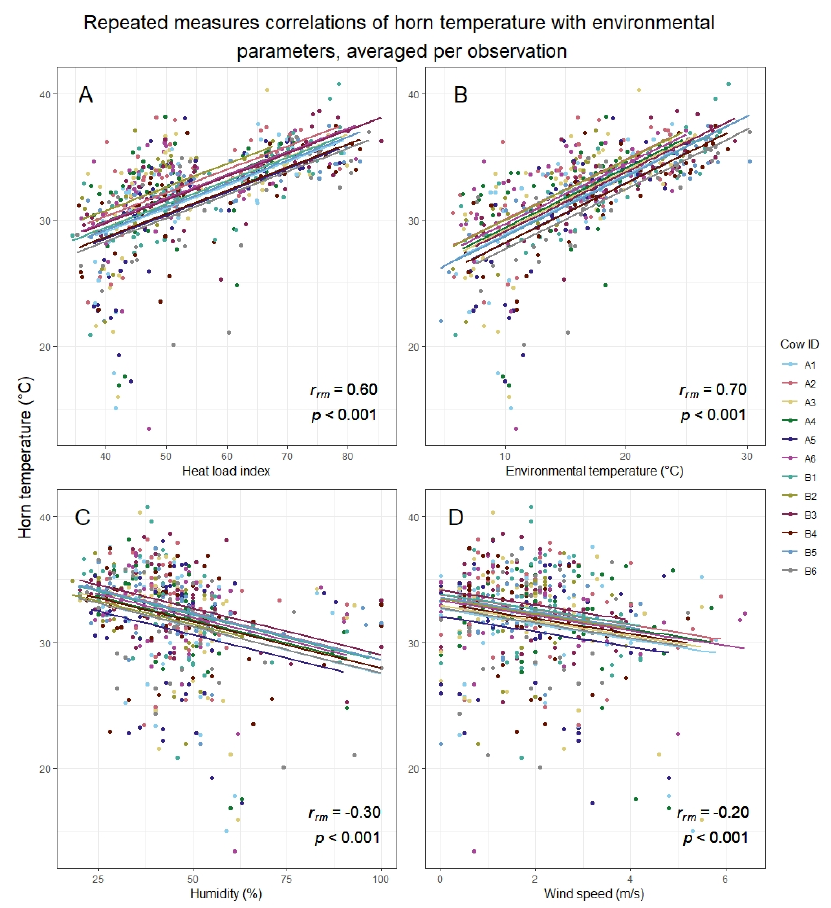
Figure 3. The repeated measures correlation (RMC) plots of horn temperature against heat load index (HLI), environmental temperature, humidity, and wind speed. For these plots, the horn temperatures were averaged per observation, resulting in 50 data points per cow. ( A ) RMC for horn temperature and HLI. ( B ) RMC for horn temperature and environmental temperature. ( C ) RMC for horn temperature and humidity. ( D ) RMC for horn temperature and wind speed. It should be noted that the heat load index combines air temperature, humidity, wind speed, and solar radiation. Therefore, the top left plot represents the influence of the parameters of the other three plots com- bined. Horn temperature did not differ during the different state behaviour categories (Kruskal–Wallis rank-sum test, Chi squared = 2, df = 3, p = 0.6, Figure 4).